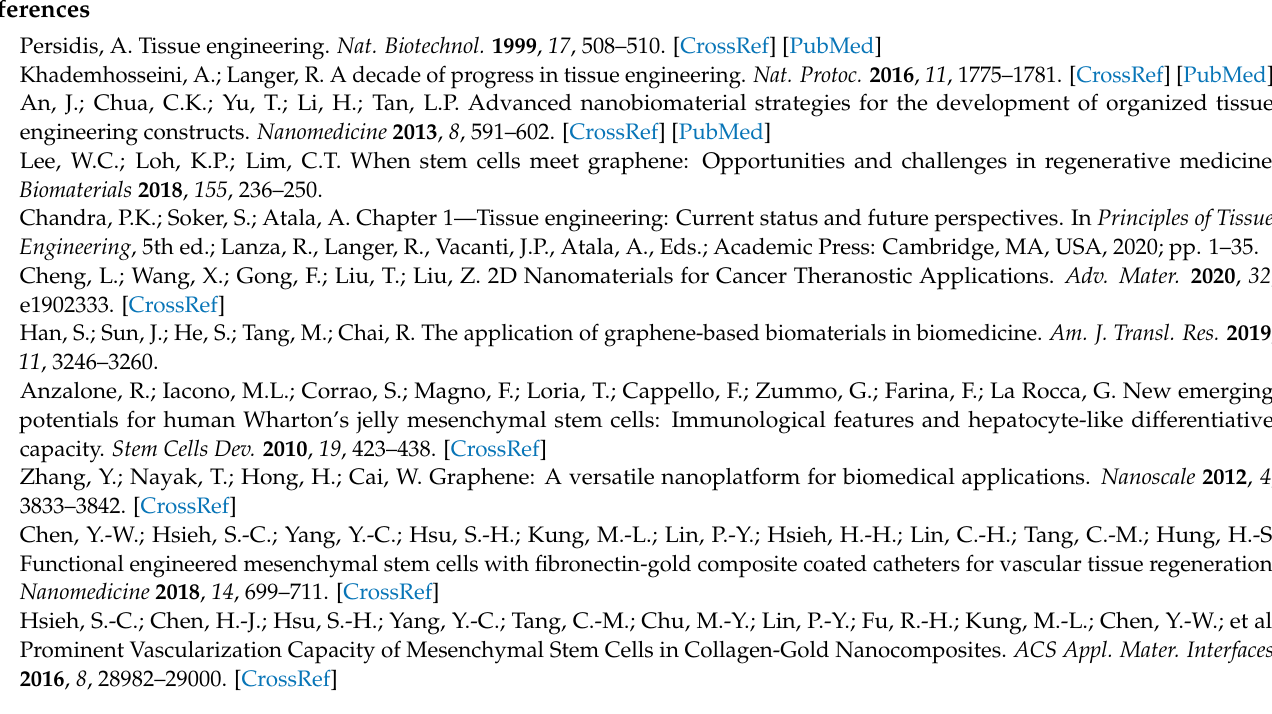
Figure S2. Effects of different materials on intracellular ROS generation; Figure S3. Characterization of GO-Au-mediated MSCs differentiation into adipocytes and